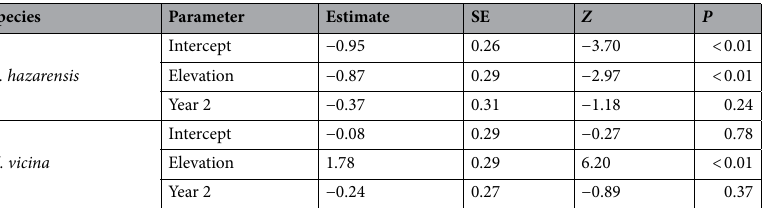
Table 4. Parameter estimates from the top-ranked (based on AIC) multispecies occupancy model for the Hazara Torrent Frog ( Allopaa hazarensis ) and Murree Hills Frog ( Nanorana vicina ) using visual observation data. Continuous covariates were standardized prior to analysis. The effect of year 2 is relative to a baseline of year 1. SE = Standard error, P = level of